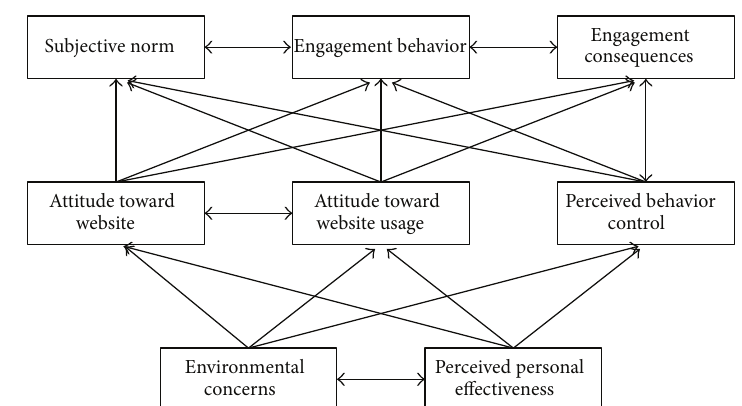
Figure 8: Three levels of structural model of model 2.